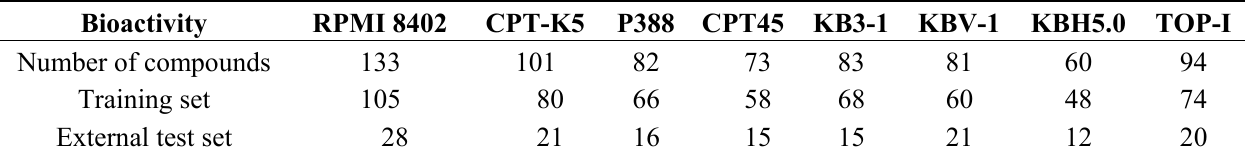
Table 2. Dataset